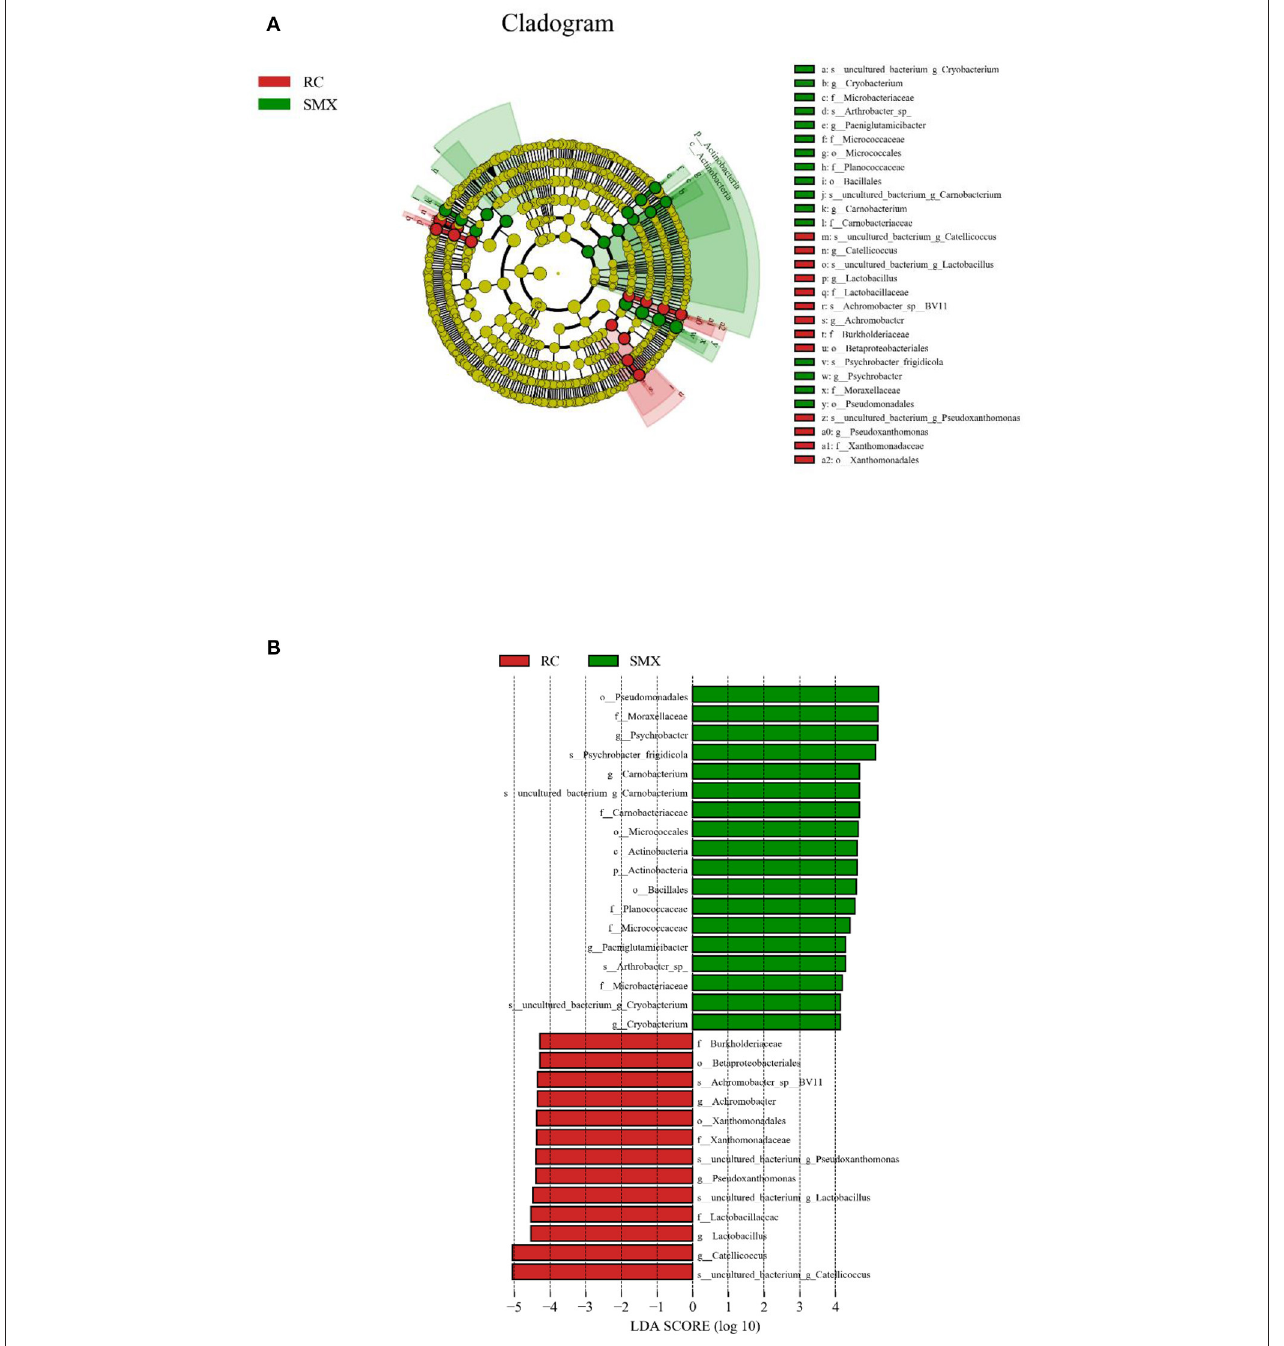
FIGURE 7 | Linear discriminant analysis effect size (LEfSe) analysis. (A) The cladogram diagram shows the microbial species with significant differences in the two groups. Red and green indicate different groups, with the species classification at the level of phylum, class, order, family, and genus shown from the inside to the outside. (B) Plot from LEfSe analysis. The plot was generated using the online LEfSe project. The length of the bar column represents the linear discriminant analysis (LDA) score. The figure shows the microbial taxa with significant differences between Sanmenxia and Rongcheng (LDA score > 4.0). demonstrating significant differences between two sites were of microbial taxa with significant differences of the two Psychrobacter , Catellicoccus , Carnobacterium , Lactobacillus , sites. On the phylum level, the biomarker demonstrating Pseudoxanthomonas , Achromobacter , Paeniglutamicibacter , and significant differences between two sites was Actinobacteria Cryobacterium (LDA > 4.0, p < (LDA > 4.0, p < 0.05). On the genus level, the biomarkers